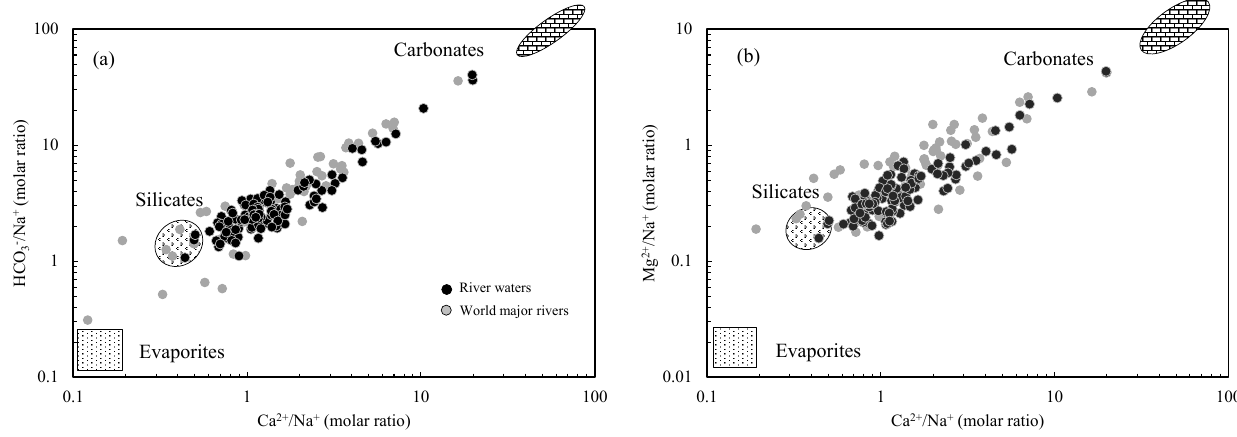
/ Na + vs. Ca 2 + / Na + and (b) Mg 2 + / Na + vs. Ca 2 + / Na + for the 3